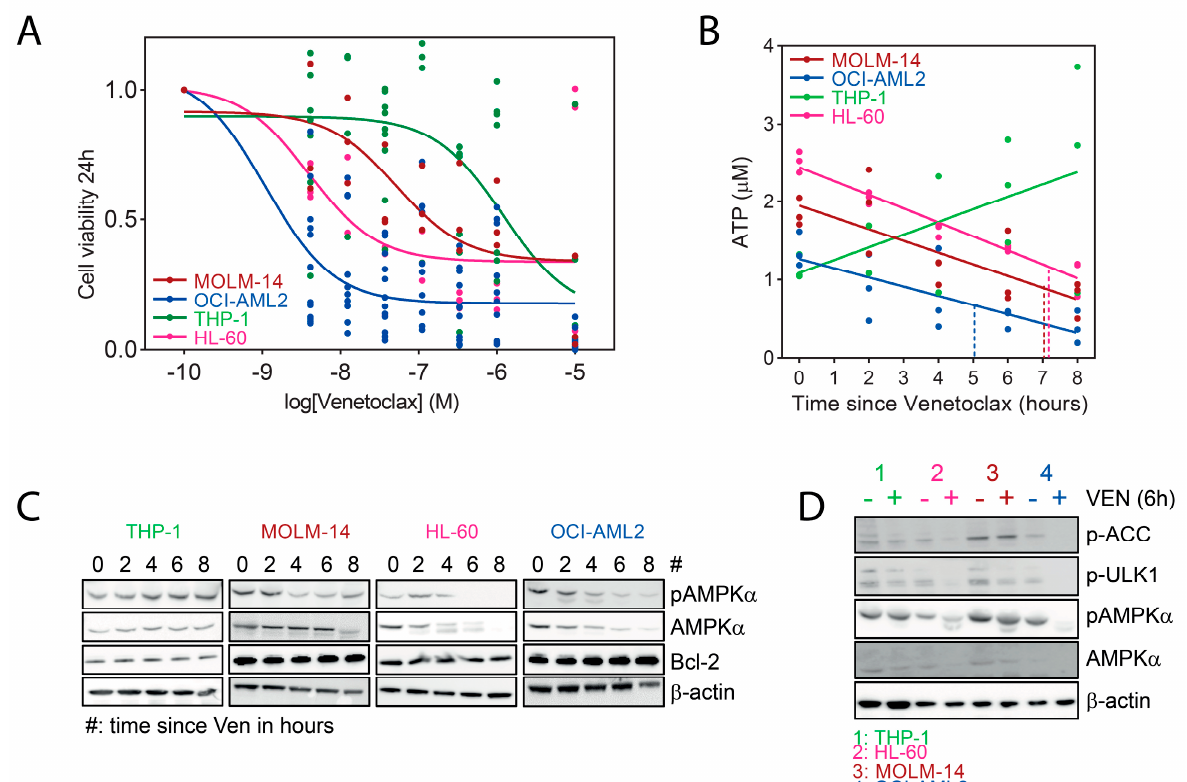
Figure 1. Inhibition of AMPK activity by venetoclax in AML cells. ( A ) Four different AML cell lines were seeded in 384-well plates at 3 × 10 5 cells/mL and incubated with a dose range of venetoclax during 24 h. Cell viability was then measured using the ATPlite luminescent reagent, and results were analyzed with the nonlinear regression module and plotted using log(inhibitor) versus response (three parameters) function of the Prism software. ( B ) Four different AML cell lines were seeded in 384-well plates at 3 × 10 5 cells/mL and incubated with 100 nM venetoclax during 0 h o 8 h. Then, ATP content was measured using the ATP lite luminescent reagent. Results of ATP content (Y-axis) were plotted on incubation time (X-axis) and a linear regression was performed using the Prism software. Time for achieving a 50% reduction of ATP content is indicated by vertical dashed lines for each cell lines following their respective color code. ( C ) AML cell lines were seeded at 5 × 10 5 cells/mL and incubated with 100 nM venetoclax for the indicated times. Western blots were performed using the anti-phospho-AMPK α T172, -AMPK α , -Bcl-2, and – β -actin antibodies. ( D ) AML cell lines were incubated with vehicle (DMSO) or 100 nM venetoclax (VEN) for 6 h, and Western blots were performed using anti-phospho-ACC S79, -phospho-ULK-1 S555, -phospho-AMPK α T172, -AMPK α , and – β -actin antibodies.